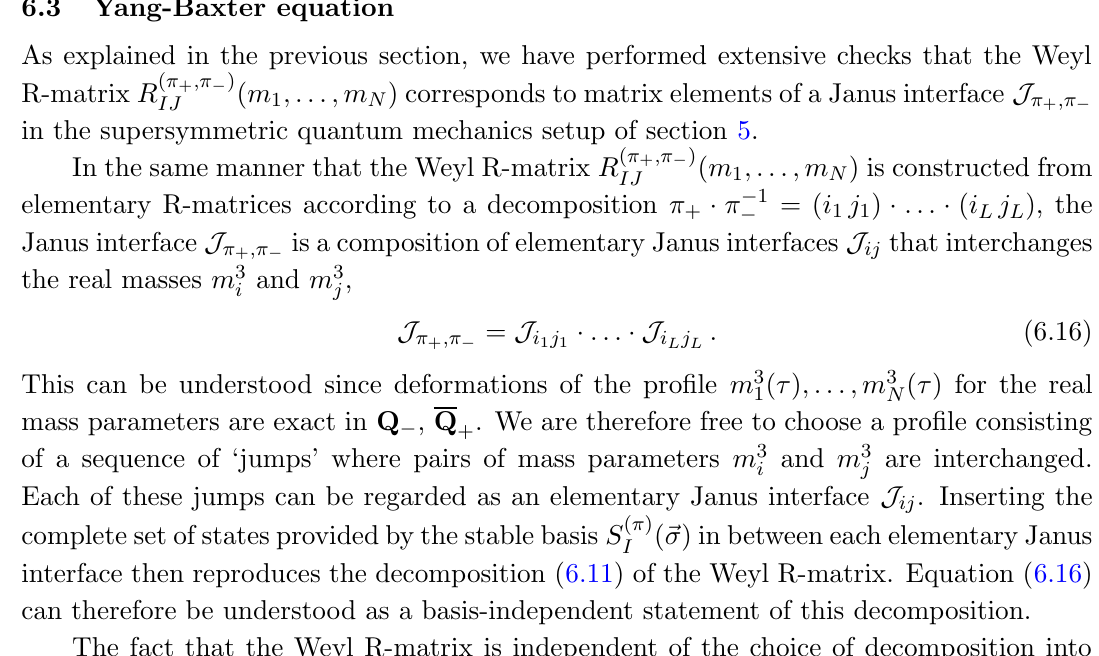
Figure 16. Decomposition of the Weyl R-matrix as a product of elementary R-matrices. The Weyl R-matrix is independent of the decomposition as a consequence of the Yang-Baxter equation ((cid:12)gure 5a) and unitarity ((cid:12)gure 5b). which can be evaluated by directly performing the contour integral in (3.16). Both of these computations give the same